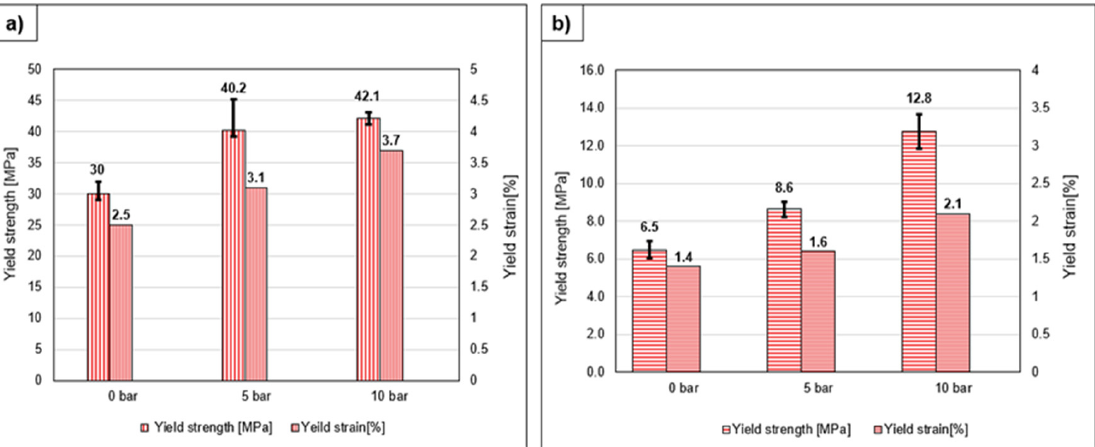
Figure 5. Yield strength and yield strain comparison of samples printed in different pressure condi- tions ( a ) longitudinal and ( b ) transverse to the printing direction.